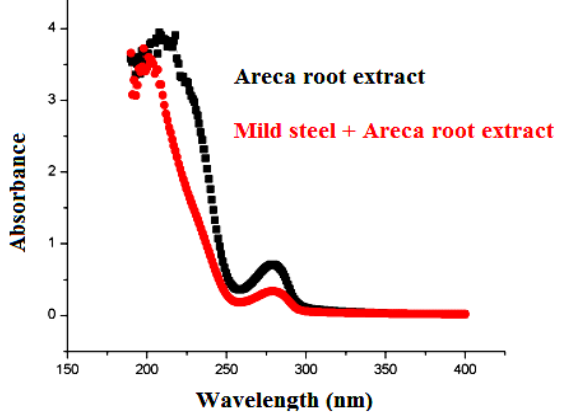
Fig. 9. UV-Visible spectroscopy results